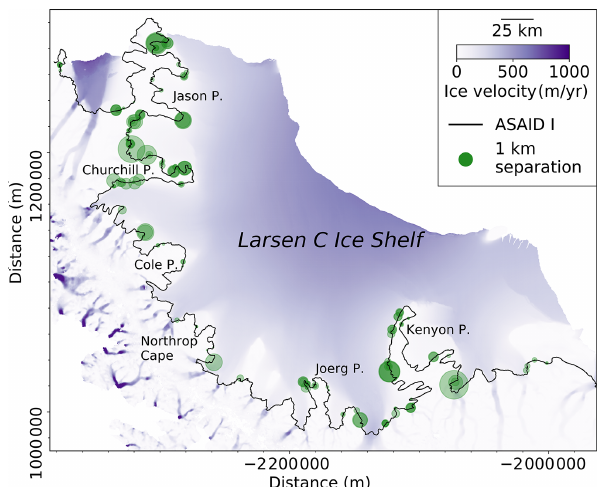
Figure A1. Absolute separations between the ICESat-2-derived inland limit of tidal flexure (Point F) and ASAID break-in-slope point (Point I). ASAID Point I is shown as the black line (Bindschadler et al., 2011). Background is the recent ice surface velocity magnitudes (Rignot et al., 2017) in Antarctic polar stereographic (epsg:3031)